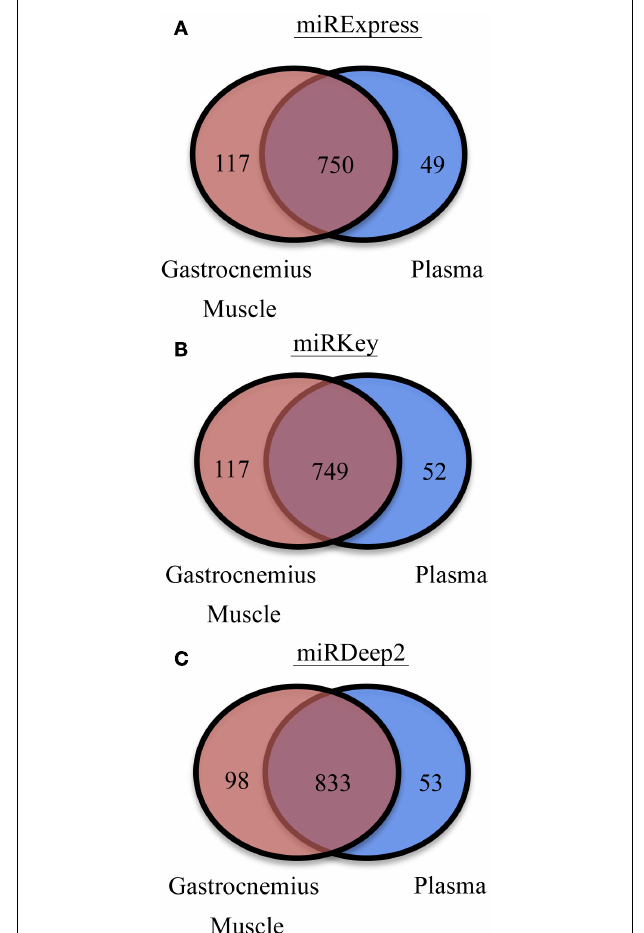
FIGURE 3 | Display of the different numbers of detectable mature miRNAs in each tissue type. (A) miRNAs detected in Gastrocnemius Muscle and Plasma by miRExpress. (B) miRNAs detected in Gastrocnemius Muscle and Plasma by miRKey. (C) miRNAs detected in Gastrocnemius Muscle and Plasma by